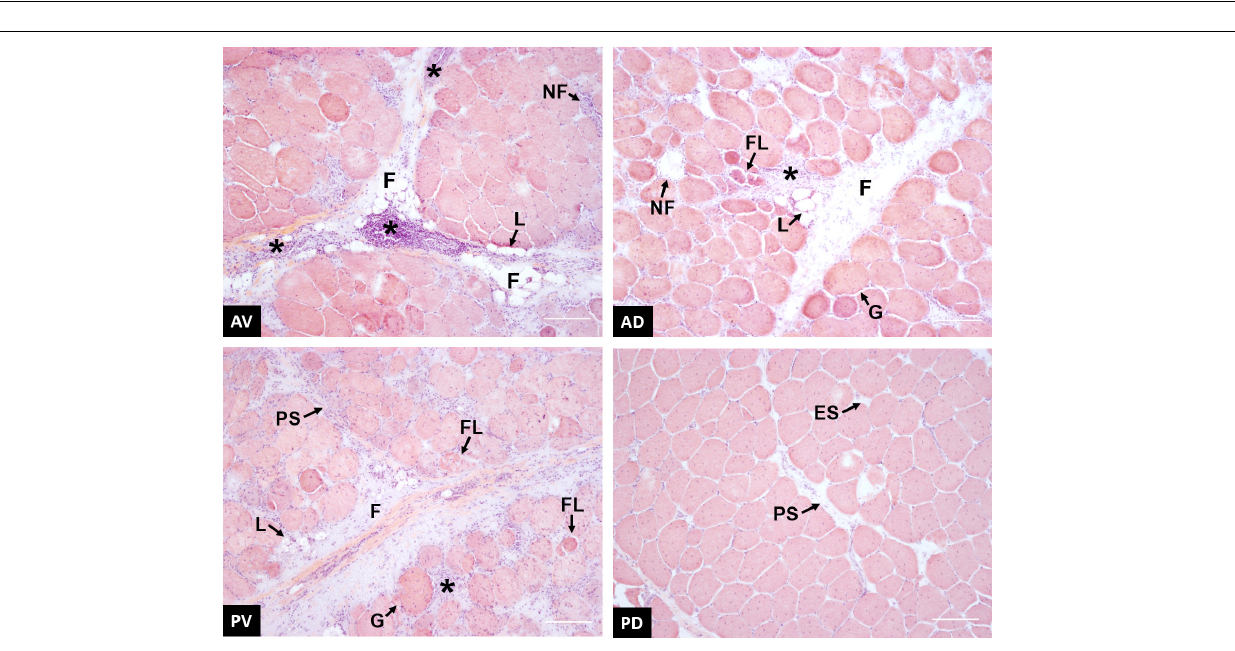
FIGURE 9 | Representative images of wooden breast (WB)-affected samples collected from anteroventral (AV), anterodorsal (AD), posteroventral (PV), and posterodorsal (PD) positions of the pectoralis major muscle. * inflammatory cells infiltrate; F, proliferation of connective tissue; L, fat tissue deposition; NF, necrotic fiber; FL, fiber lysis; PS, perimysial spacing; ES, endomysial spacing; G, giant hypertrophic fiber. Scale bar = 150 µ